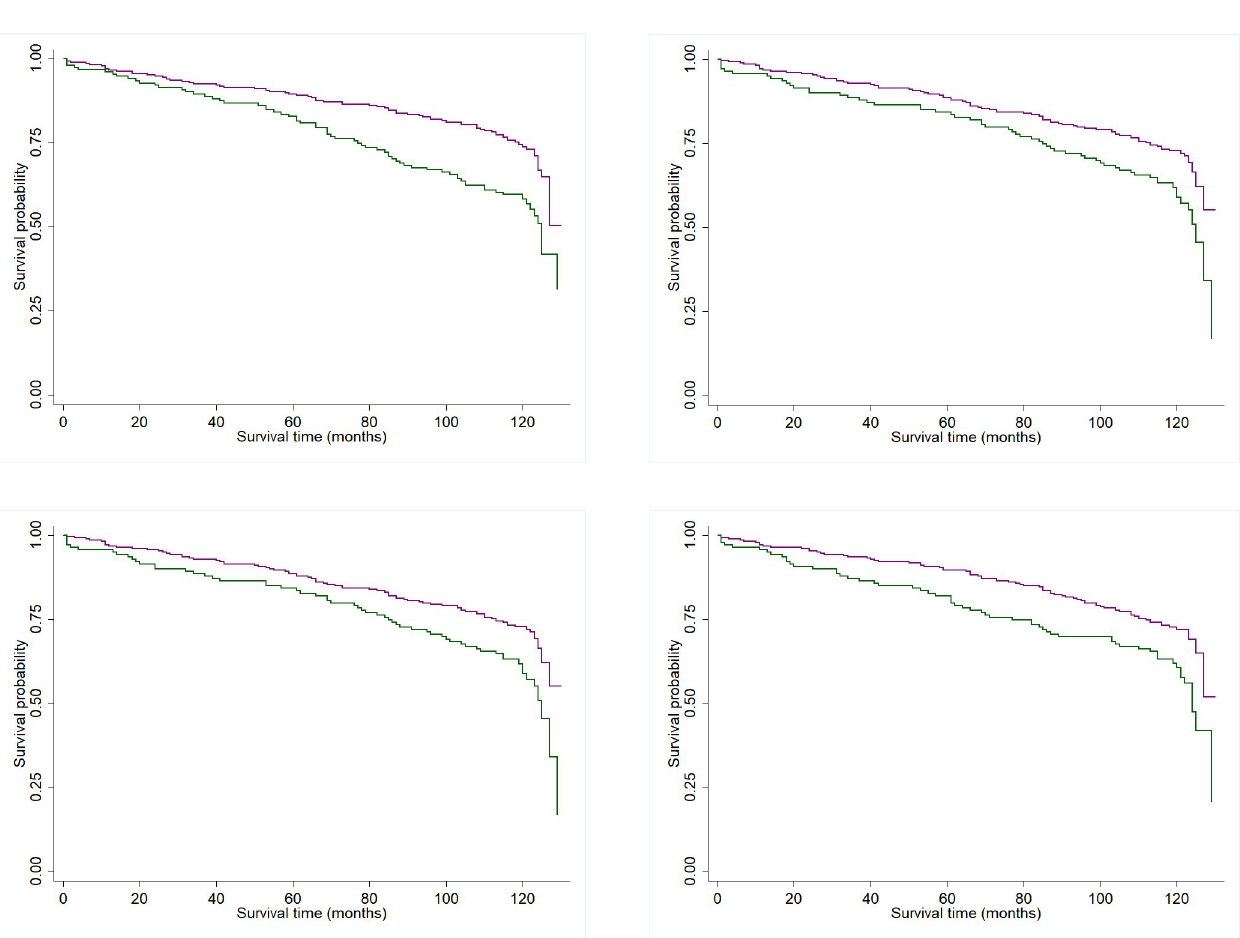
Fig 1. Survival curves of the population studied according to the anthropometric measurements ( — Normal; — Low). (A) Normal Calf circumference; Low Calf circumference. (B) Normal Mid-Arm circumference; Low Mid-Arm circumference. (C) Normal Mid-Arm muscle circumference; Low Mid-Arm muscle circumference. (D) Normal Corrected arm muscle circumference; Low Corrected arm muscle